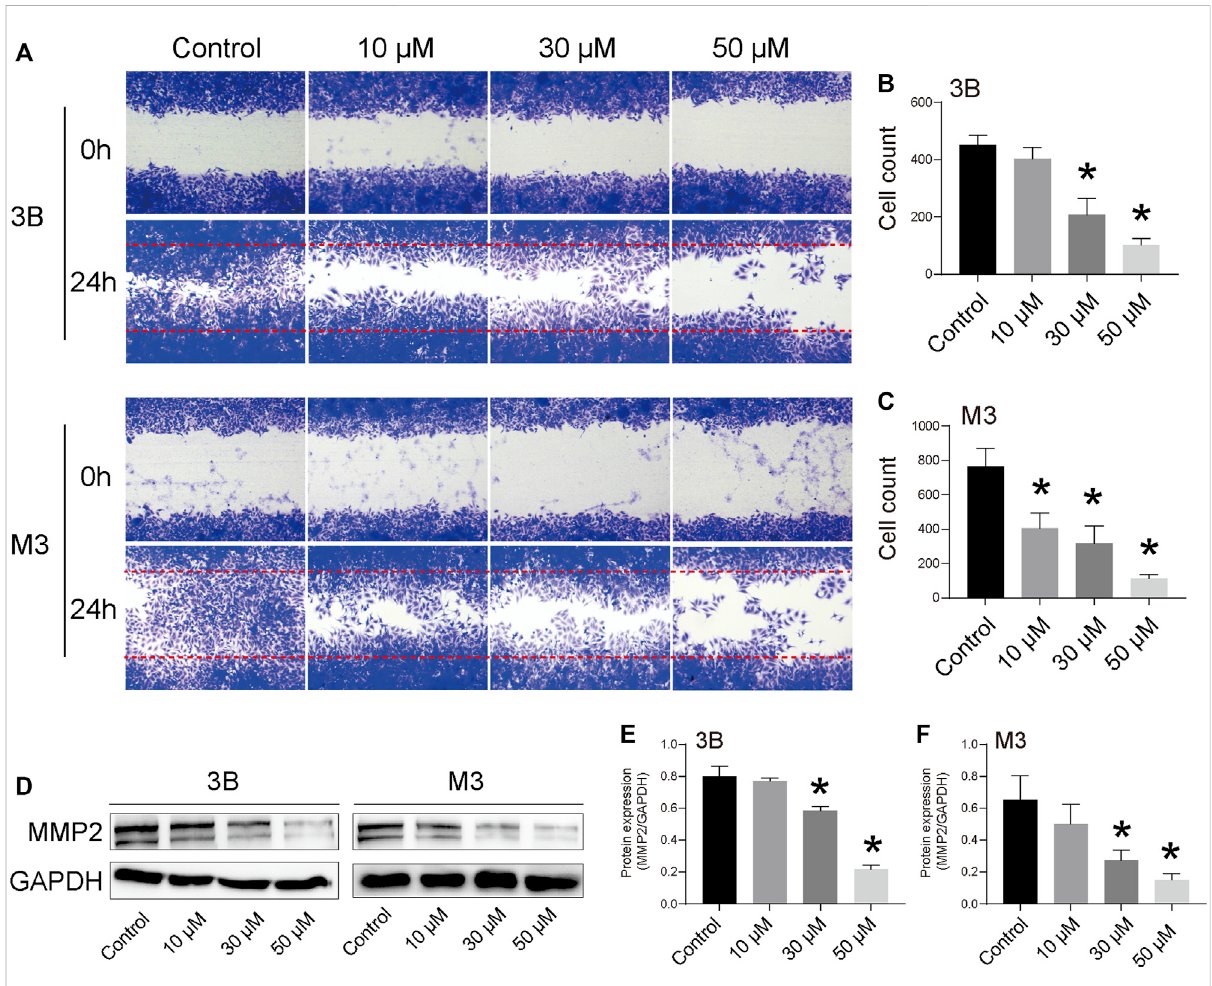
FIGURE 3 STA inhibits Hep3B and HCCLM3 cell migration. (A) Scratch assay was performed to determine migration of Hep3B and HCCLM3 cells treated withSTAatfor48 h. (B,C) Quanti fi cationofthescratchimagewasperformedbycalculatingthemigratedcellcountsin (A) . (D – F) Therepresentative bands of MMP2 in Hep3B and HCCLM3 cells treated with STA for 48 h. GAPDH was used as an internal control. Data shown are means ± SD; n = 3. * p < 0.05, signi fi cantly from control